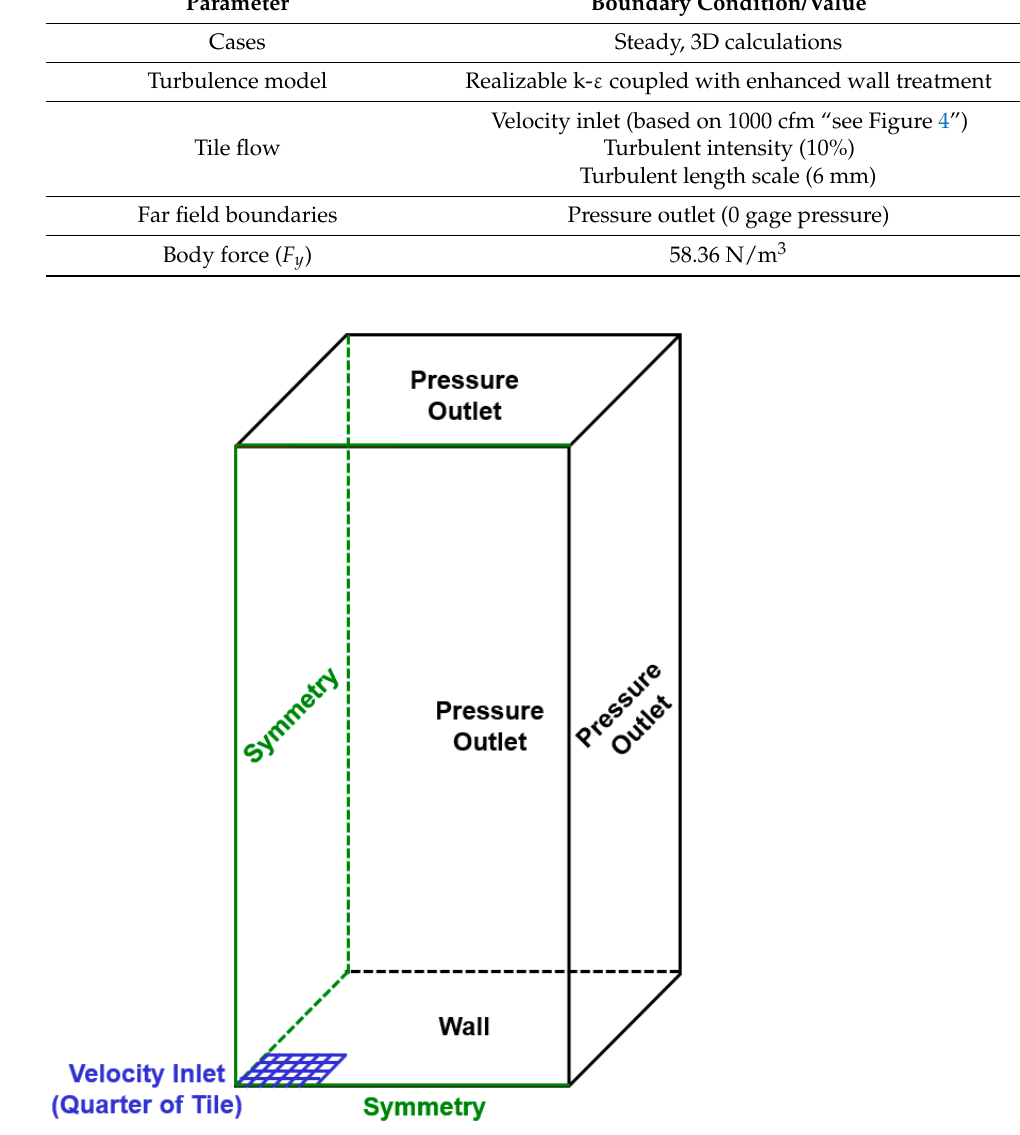
Figure 2. Computational domain for multiple openings tile model.